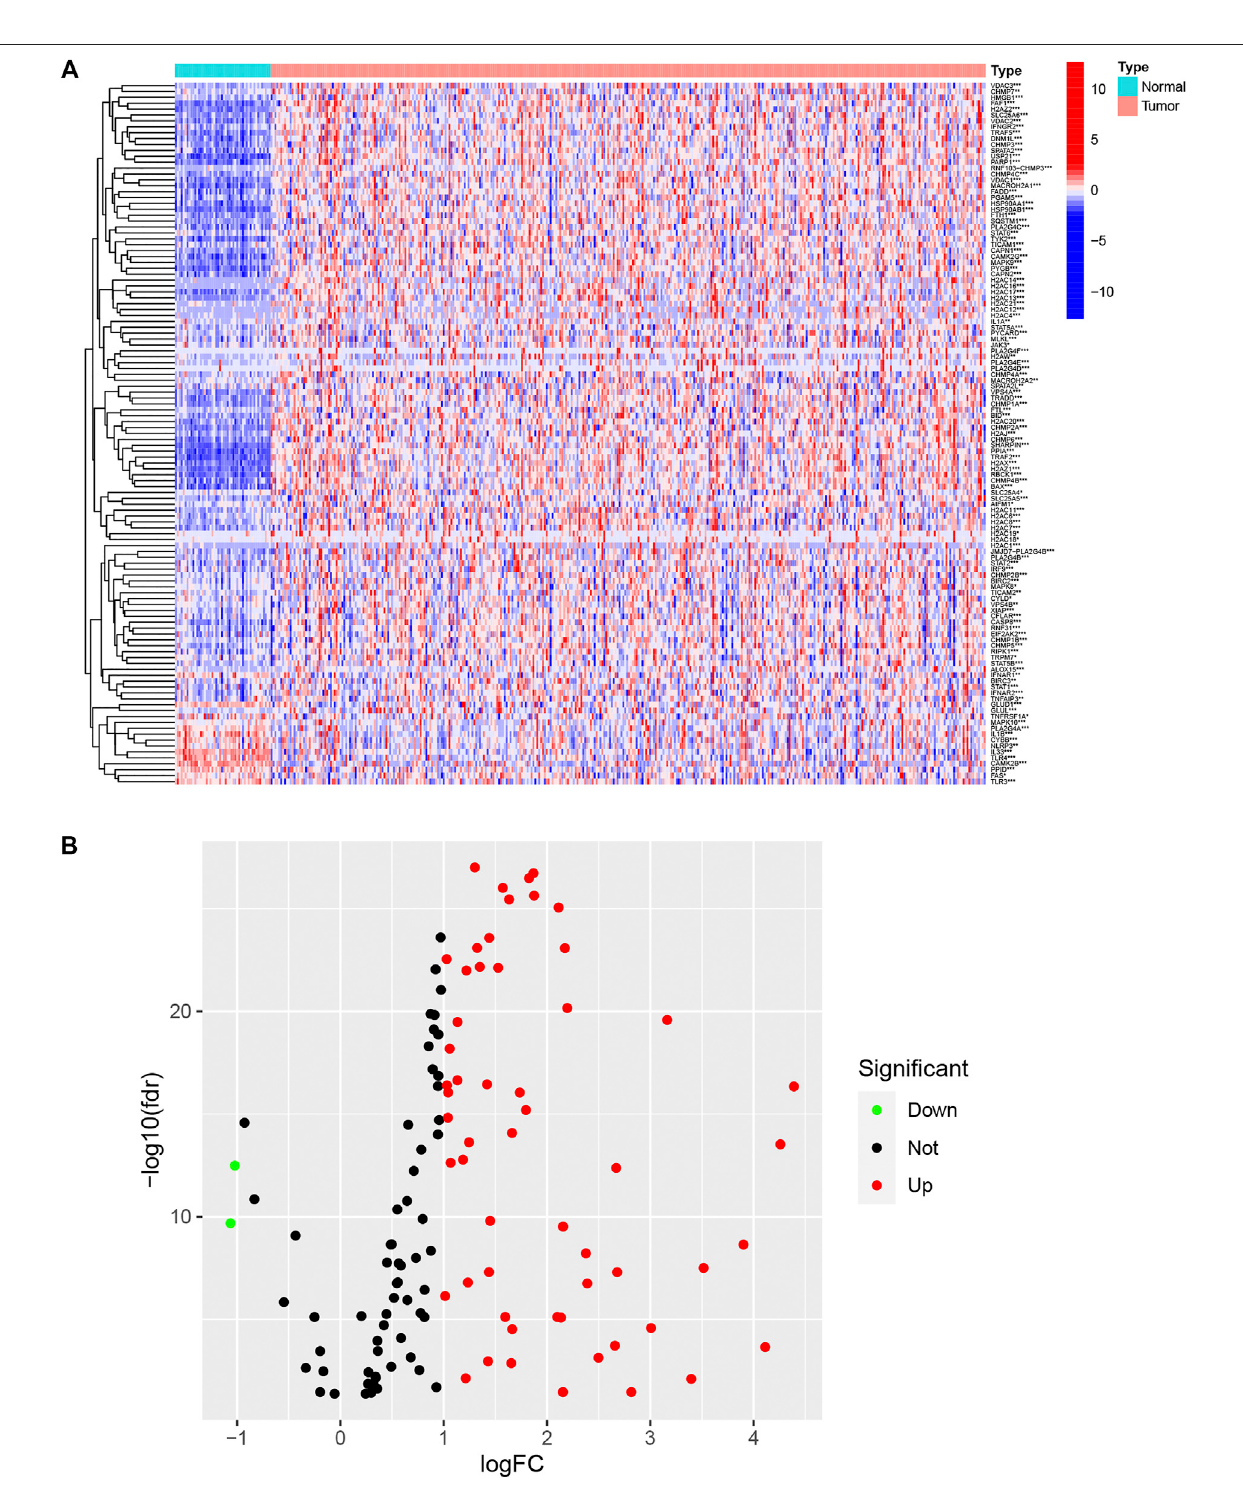
FIGURE 1 | Expression of necroptotic regulators in LIHC and normal tissues. (A) Heatmap showing expression of necroptotic regulators between tumor and normal tissues. (B) Volcano plot showing fold changes of necroptosis regulators between tumor tissue and normal tissue. * p < 0.05, ** p < 0.01, and *** p < 0.001.